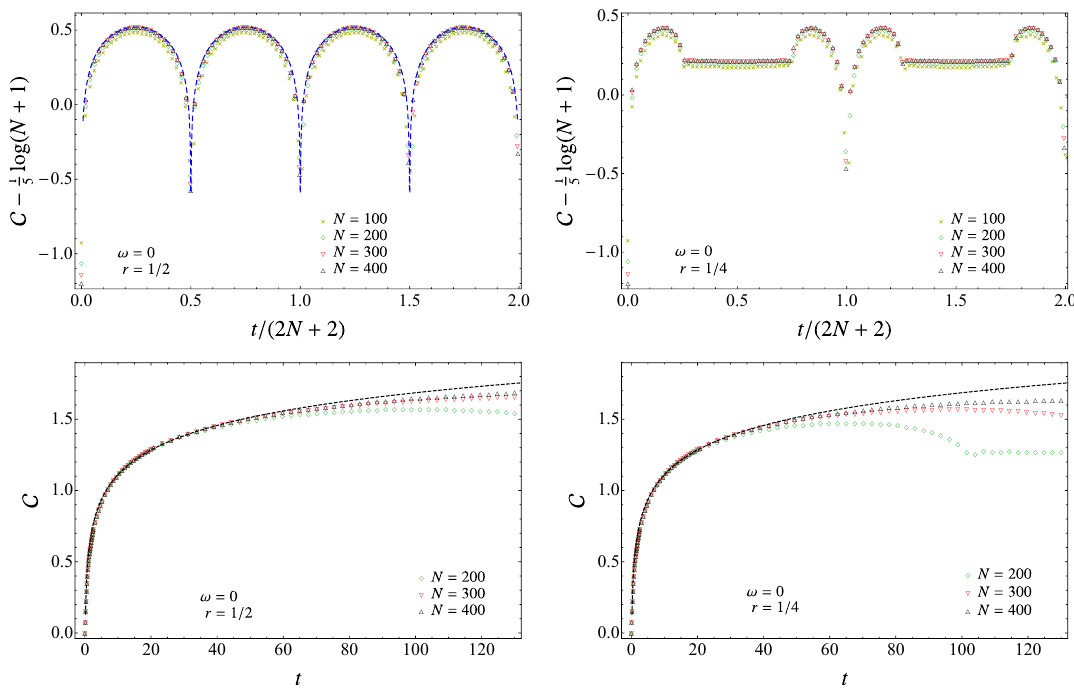
Figure 2 . Temporal evolution of the complexity C in (3.1) for the entire chain (made by N sites) after a local quench with ω = 0 w.r.t. the initial state at t = 0 . Here either r = 1 / 2 (left panels) or r = 1 / 4 (right panels). The dashed curve in the top left panel corresponds to (3.24), while the ones in the bottom panels are obtained from